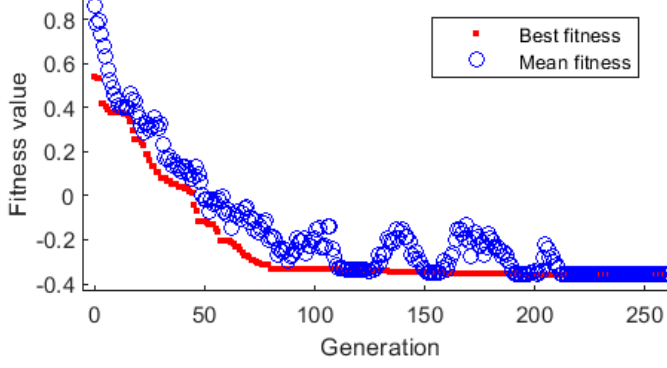
Figure 18. Genetic algorithm—the best fitness plot.